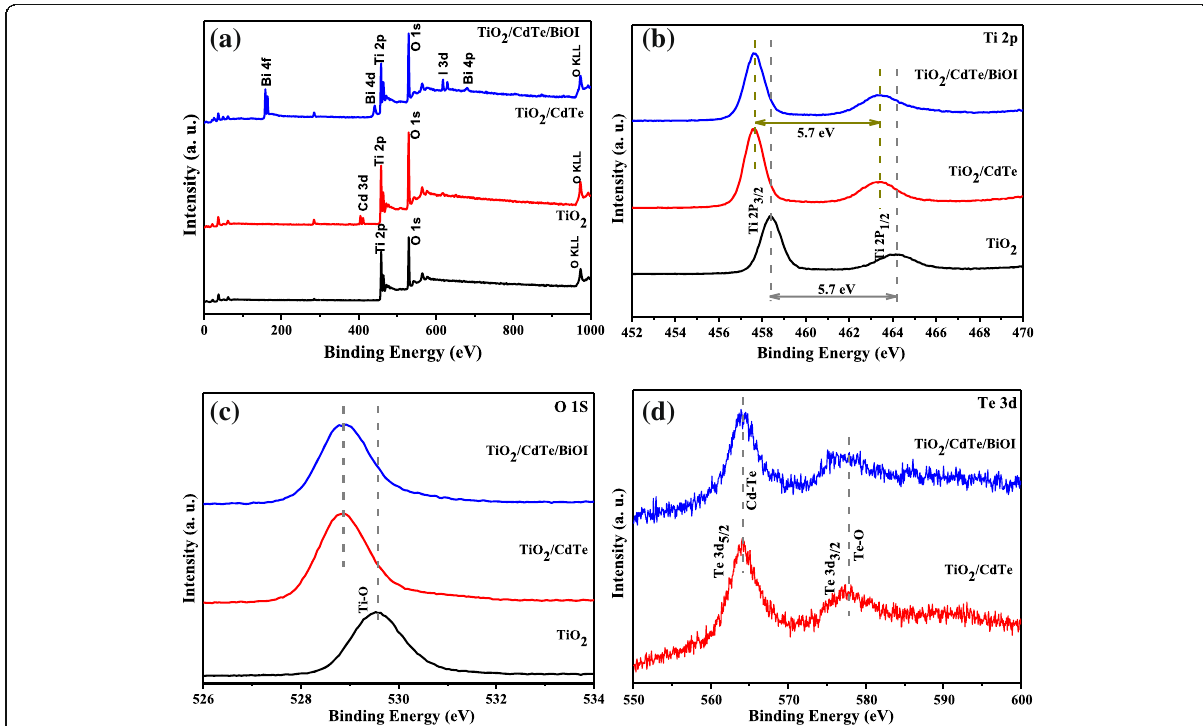
Fig. 5 a XPS scanning spectrum of the samples of TiO 2 , TiO 2 /CdTe, TiO 2 /CdTe/BiOI. b – d High-resolution XPS spectra of Ti, O, and Te